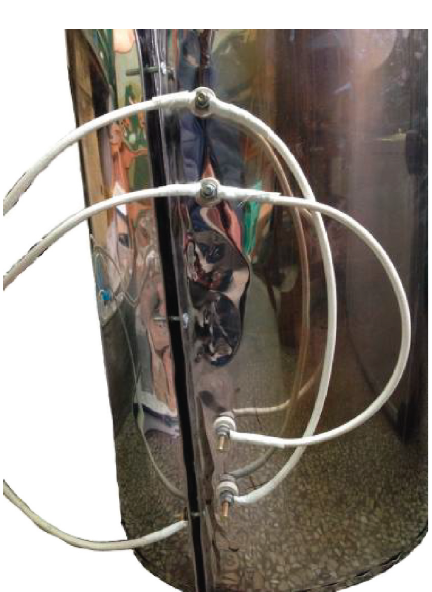
Figure 5: Arrangement of the strain gauge.